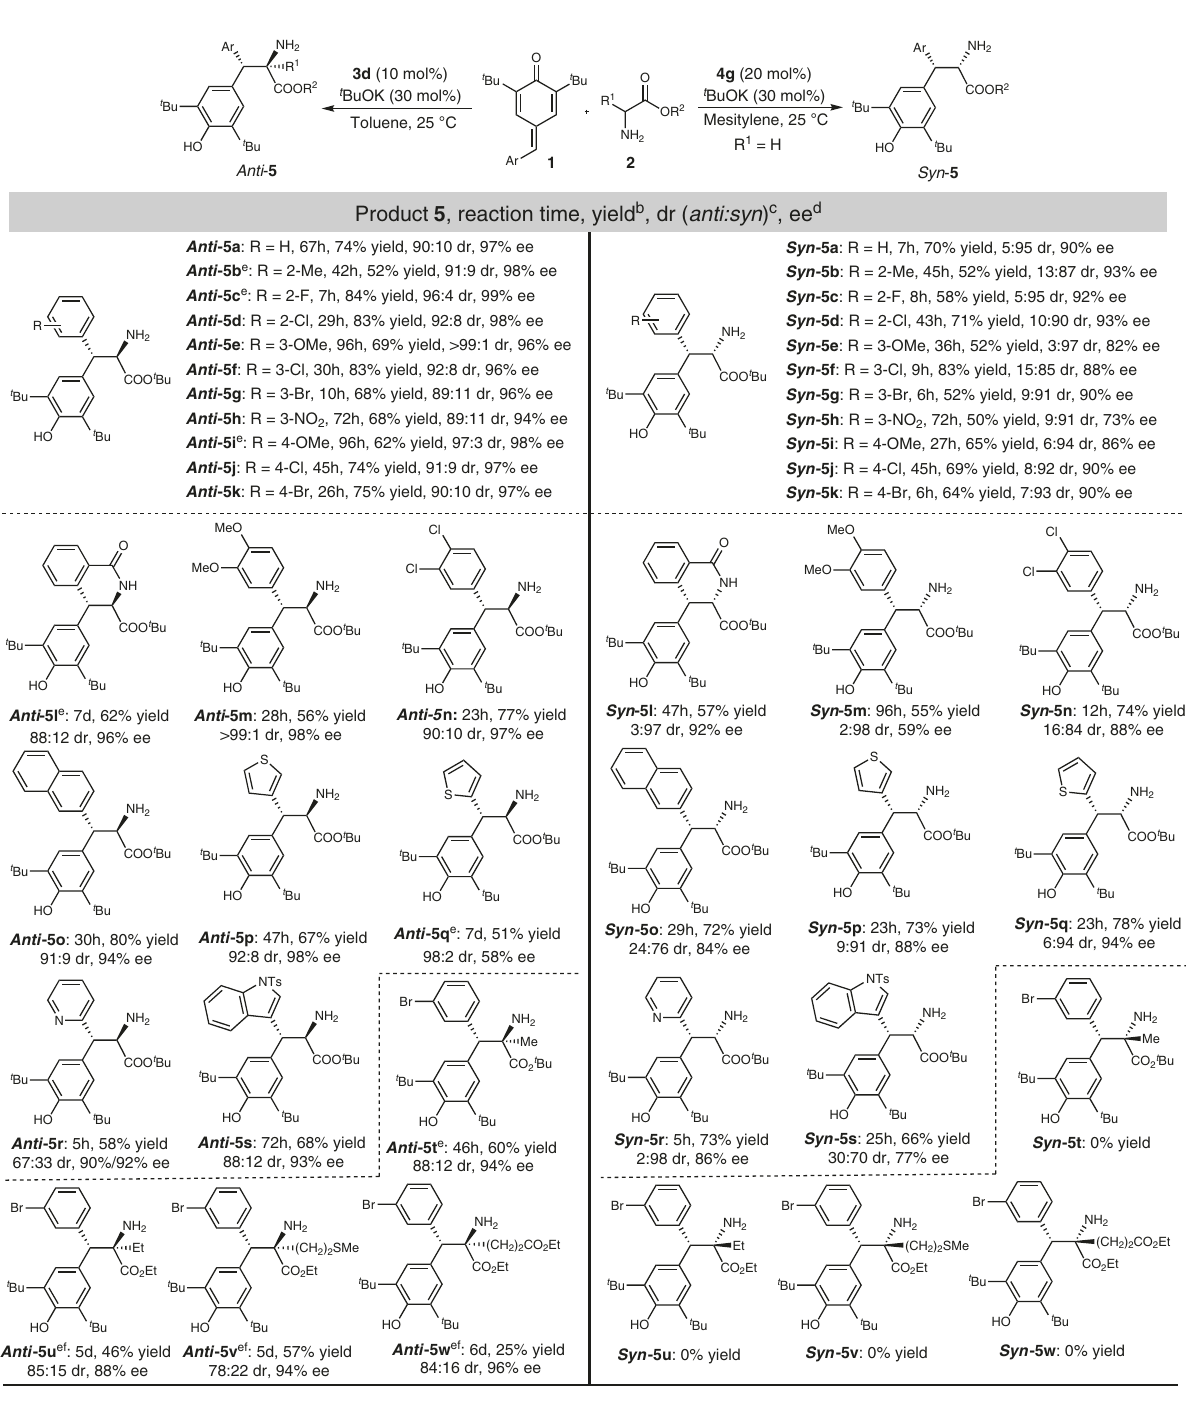
Fig. 2 Substrate scope of the 1,6-conjugated addition reaction a . a Reaction conditions: 1 (0.1 mmol), 2 (0.2 mmol), 3d (0.01 mmol) or 4g (0.02 mmol), t BuOK (0.03 mmol), PhCH o C. b Isolated yield. c Determined by 1 H NMR. d Ee of the major diastereoisomer 3 (1.0 mL) or mesitylene (0.5 mL), at 25 determined by chiral HPLC. e Using 20 mol % 3d . f At 35 o